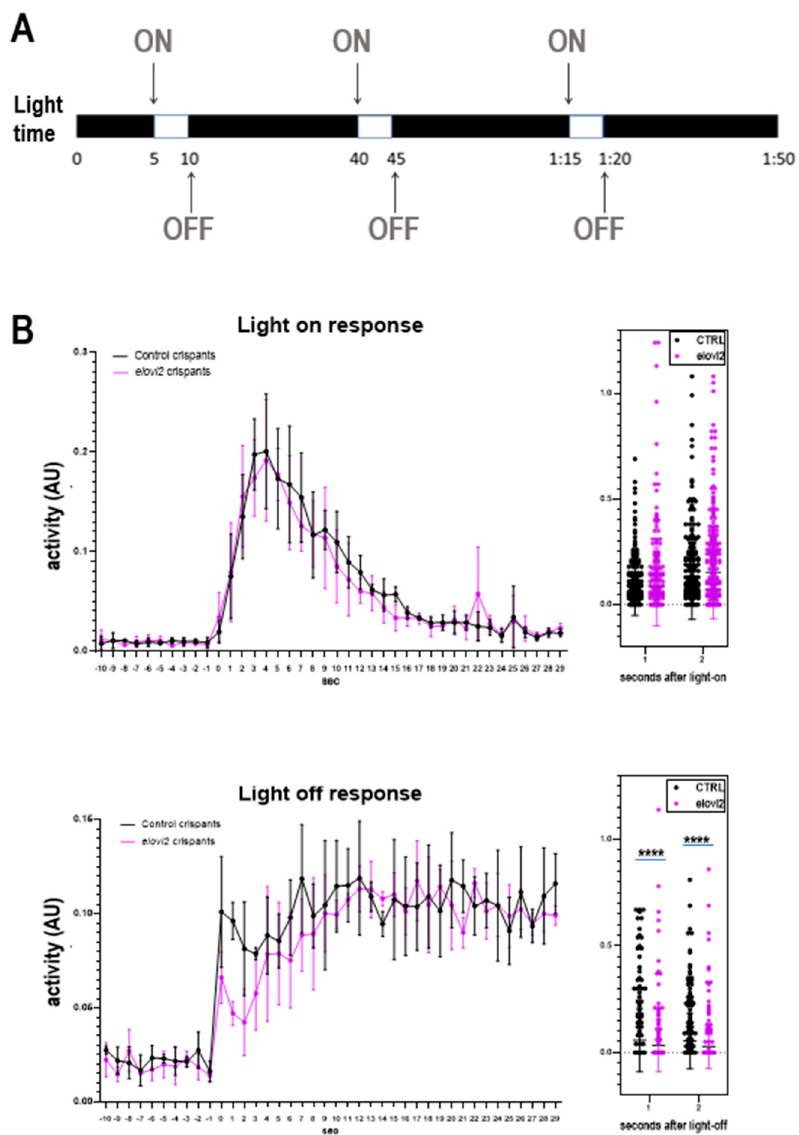
Figure 5. Zebrafish elovl2 crispants show deficits in the visual motor response (VMF). OFF response activity show visual phenotype. ( A ) Diagram of motor response (VMR) assay. ( B ) Motor response of control and elovl2 crispants to VMR-ON (top) and VMR-OFF (bottom) stimulus. Right Charts: quantification of the results at second 1 and 2 after the light stimulus change. AU, arbitrary unit.